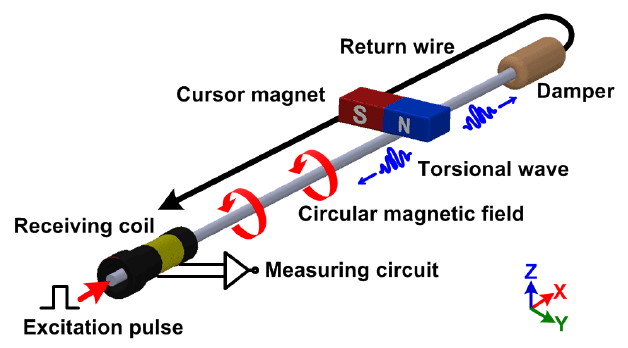
Figure 1. Principle of